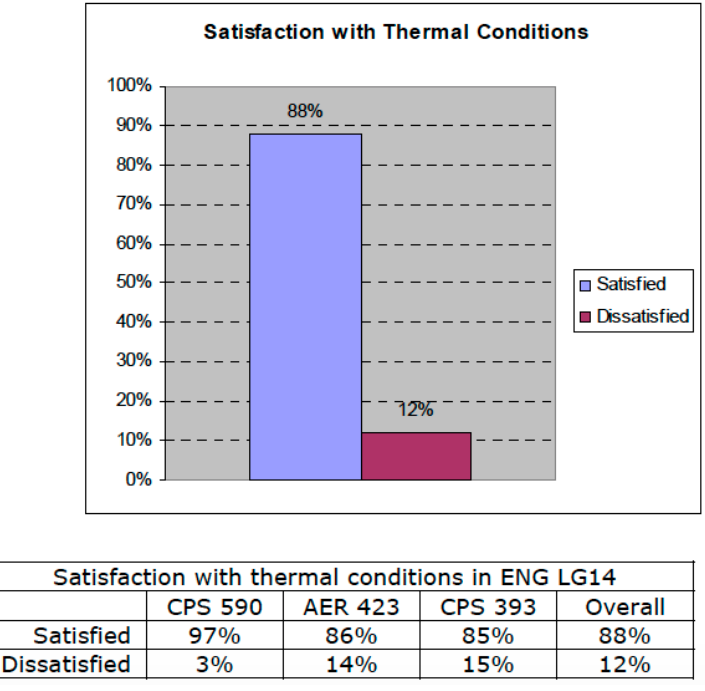
Figure A3. Thermal Satisfaction Survey Results.